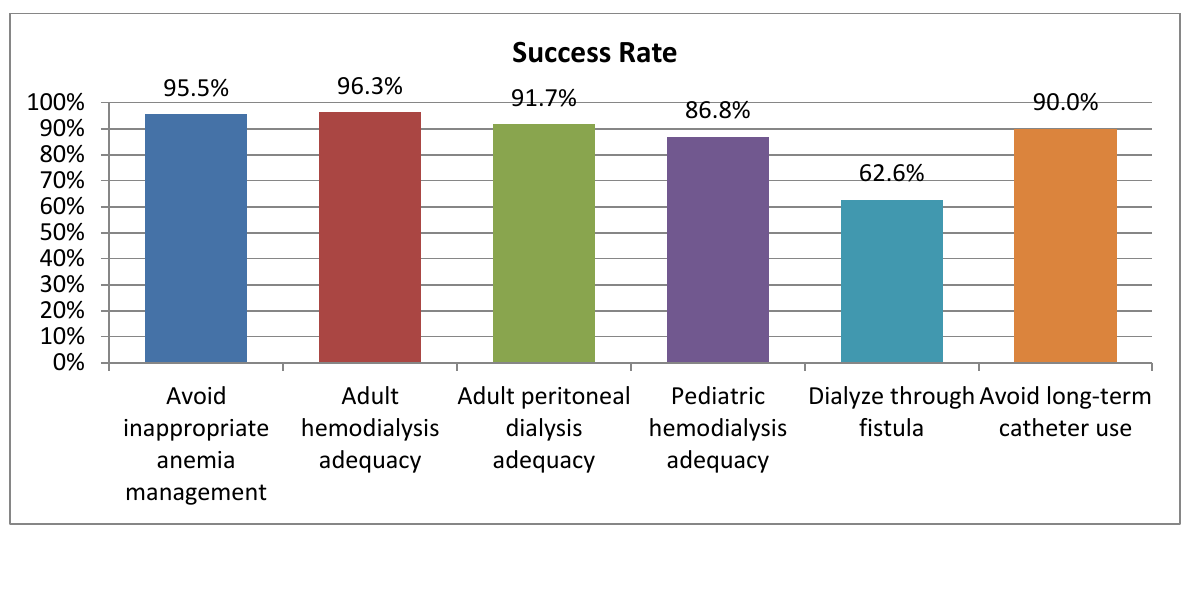
Figure 11.2: Average performance on ESRD QIP clinical quality